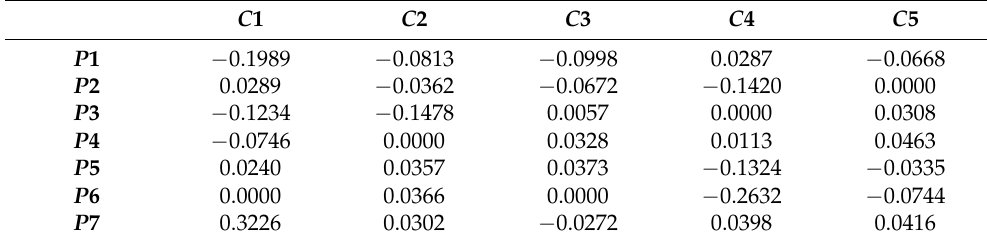
Table 8. Cooperative enterprise prospect